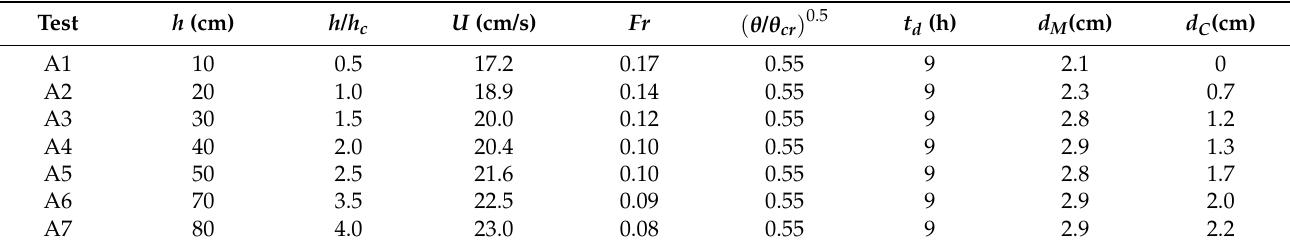
Table 1. Tests for the influences of flow depths.